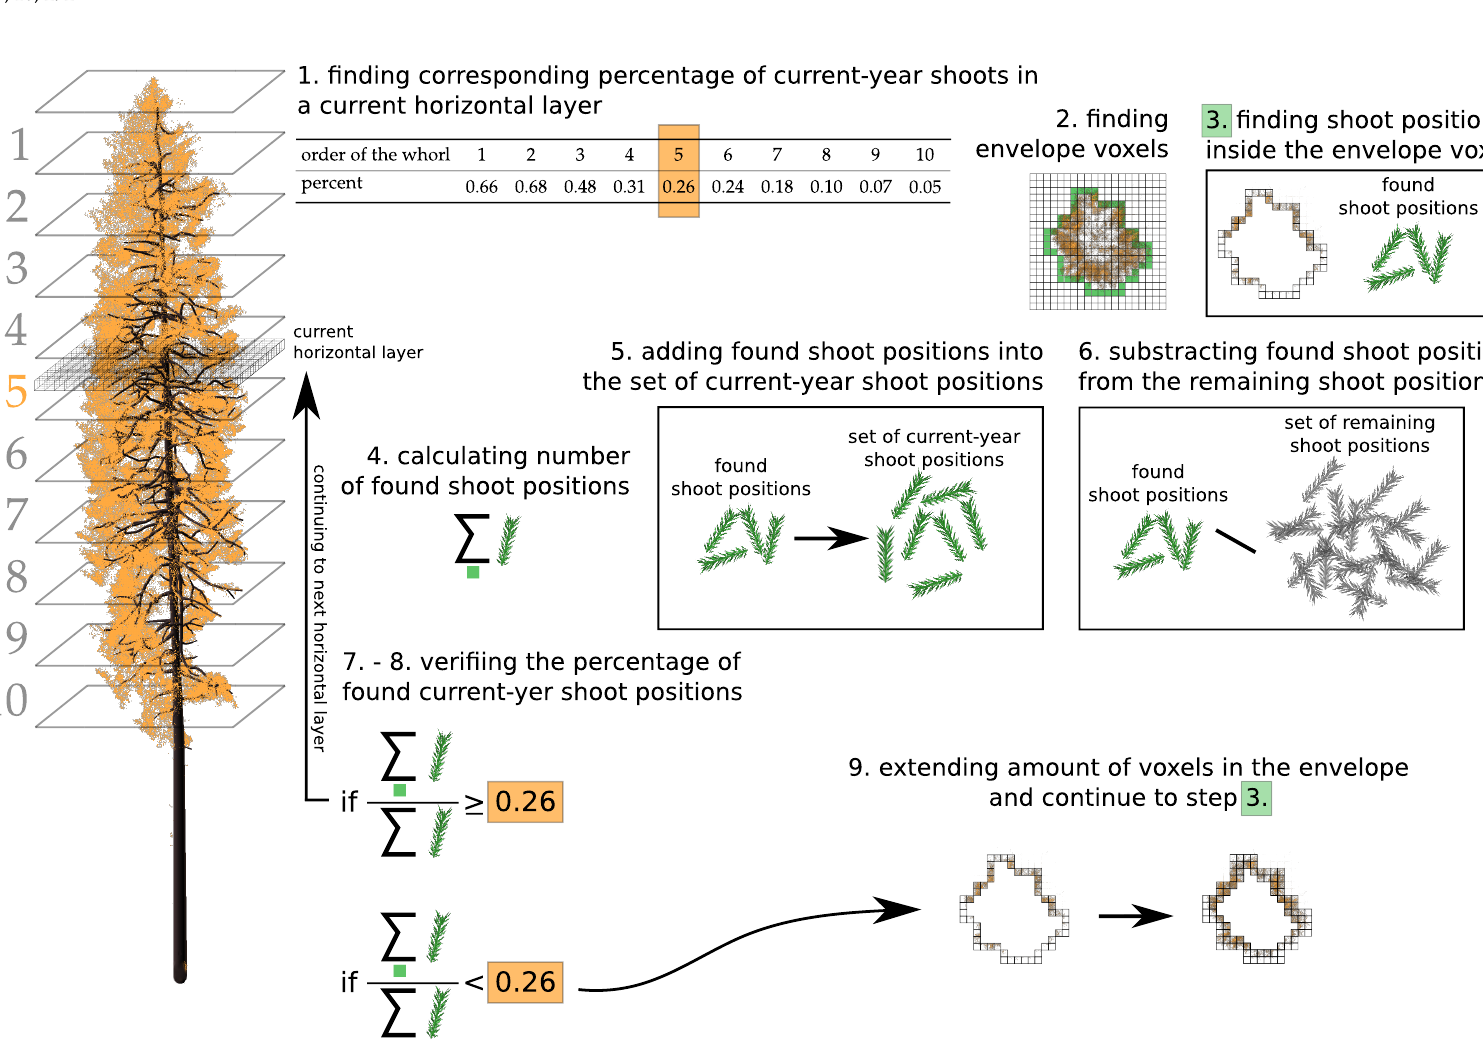
Figure A3. The process of separating and finding crown envelope. The process iterates through every voxel, one by one, so long as there are still points from foliage point